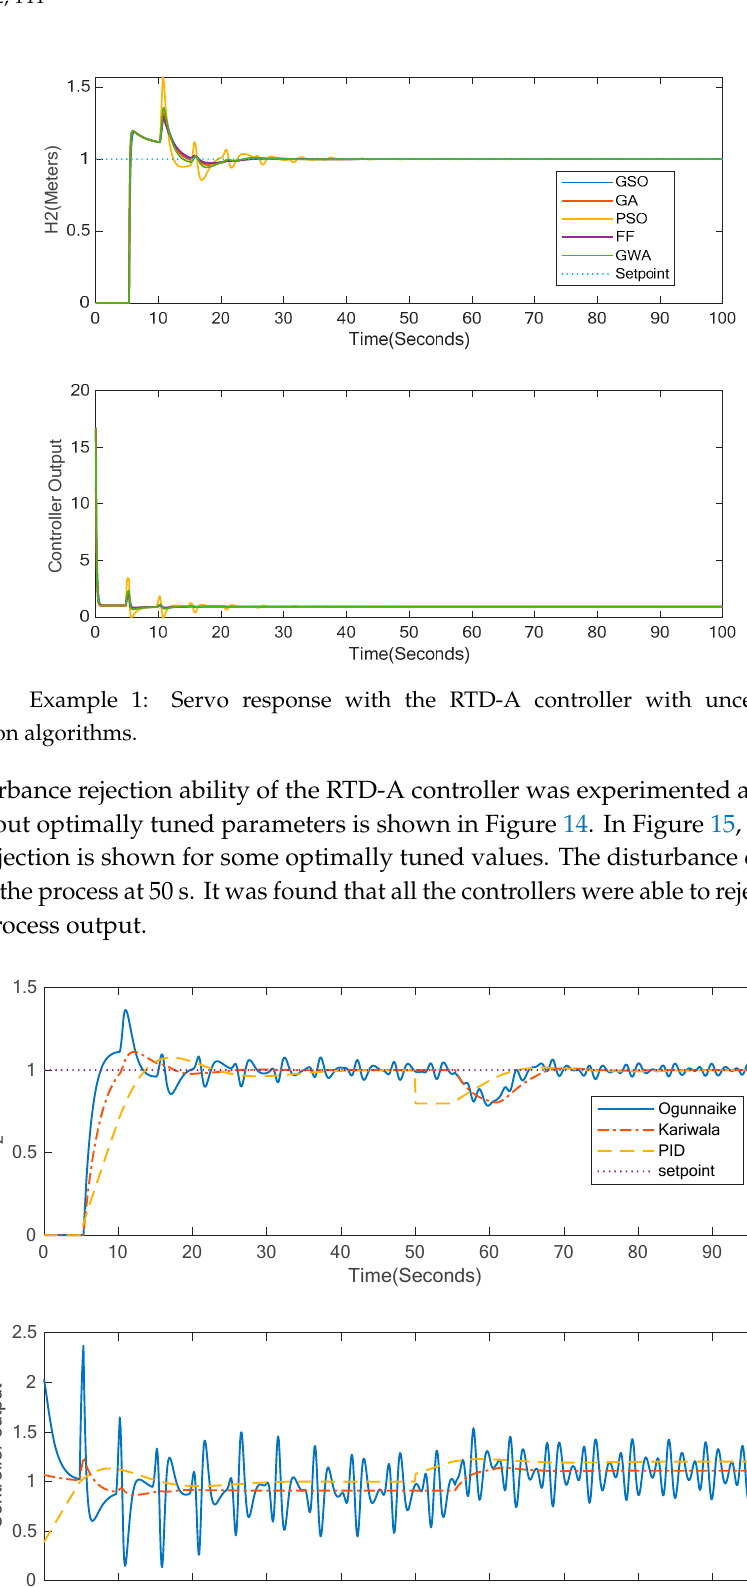
Figure 12. Example 1: Servo response with the RTD-A controller with disturbance and uncertainties.